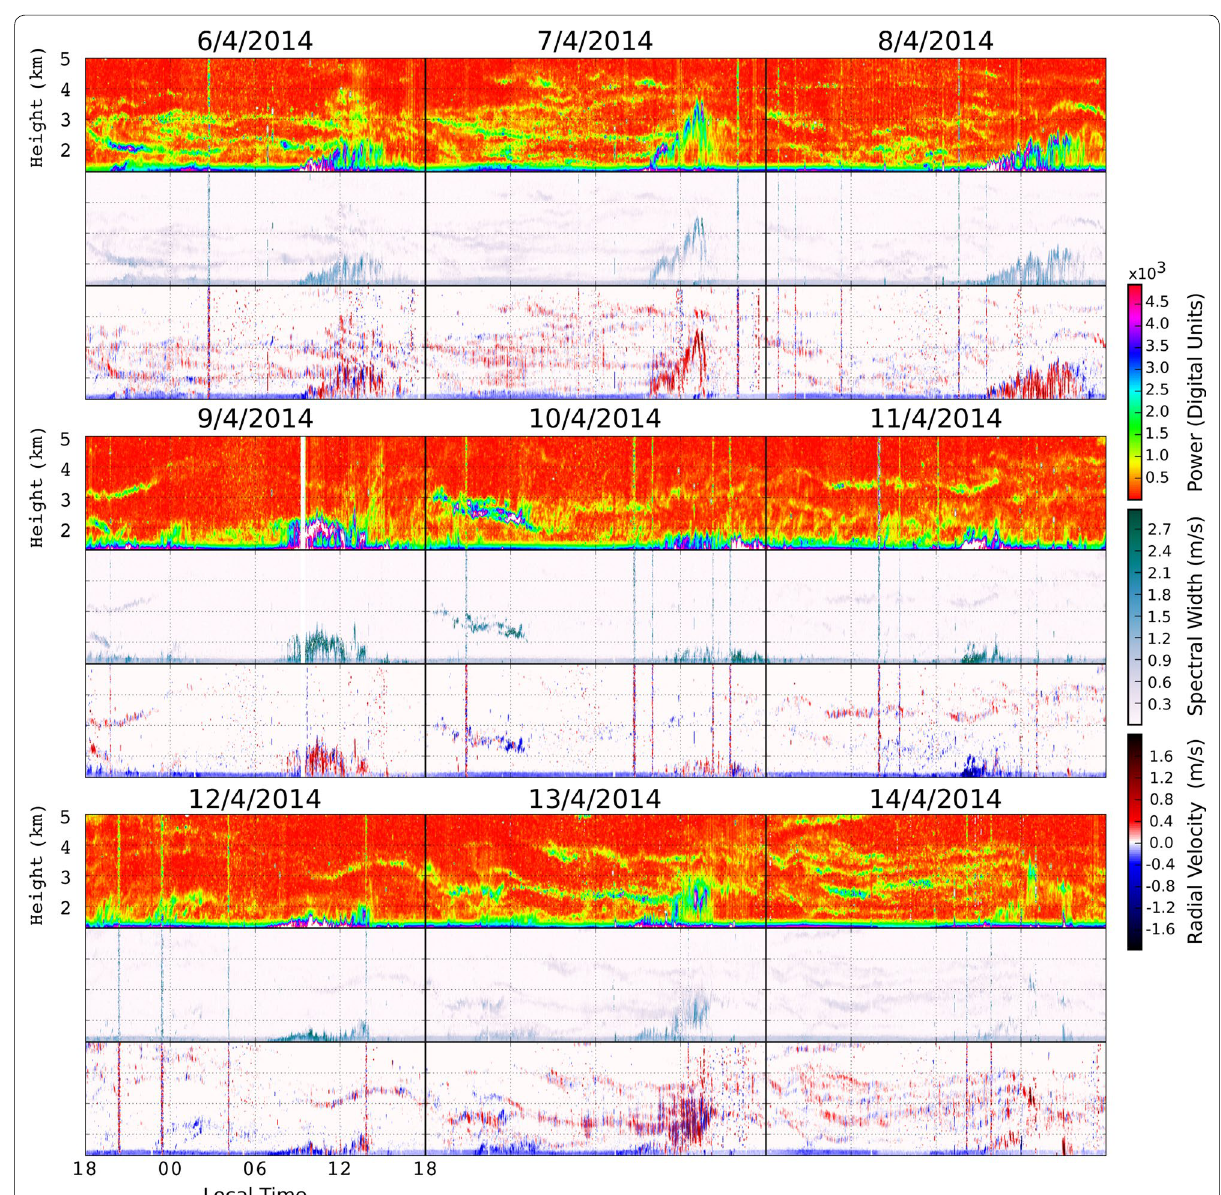
Fig. 2 Radar products for nine consecutive days, from April 6th to April 14th (2014). Three days per panel are shown with the dates specified at the top. Each day contains three graphs, these being (from top to bottom) (1) Integrated power, (2) Spectral width, and (3) Radial Velocity. The amount of time when no echo layer is observed is scarce. On occasions as many as five simultaneous echo layers could be observed (e.g., April